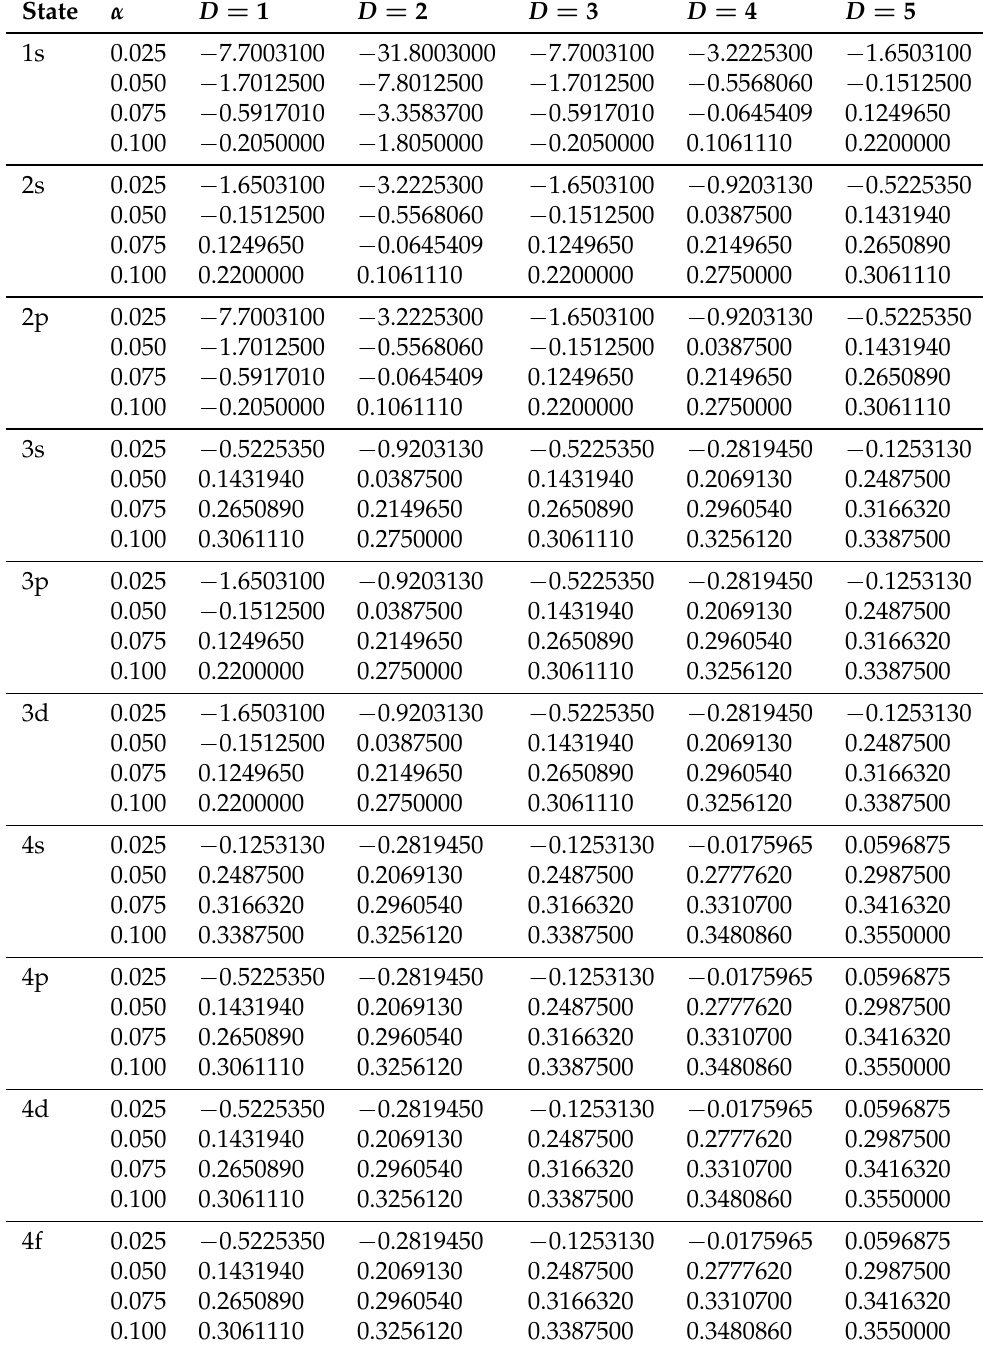
Table 1. Numerical non-relativistic energy spectra of the